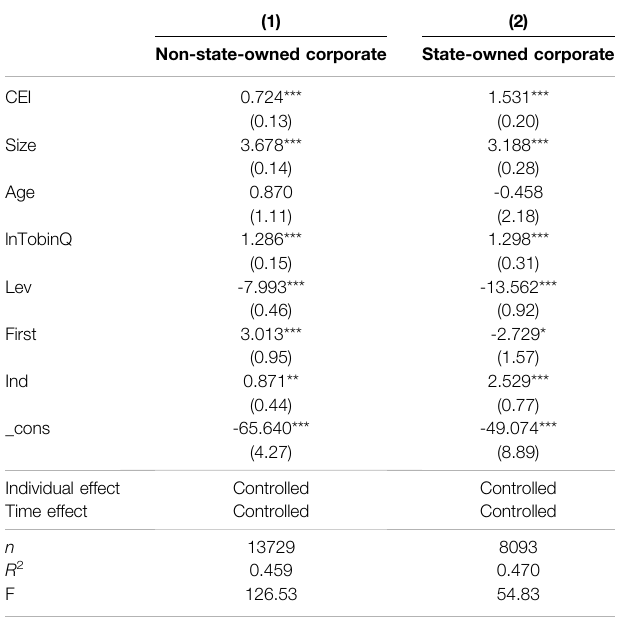
TABLE 11 | Heterogeneity test for equity nature of corporates.